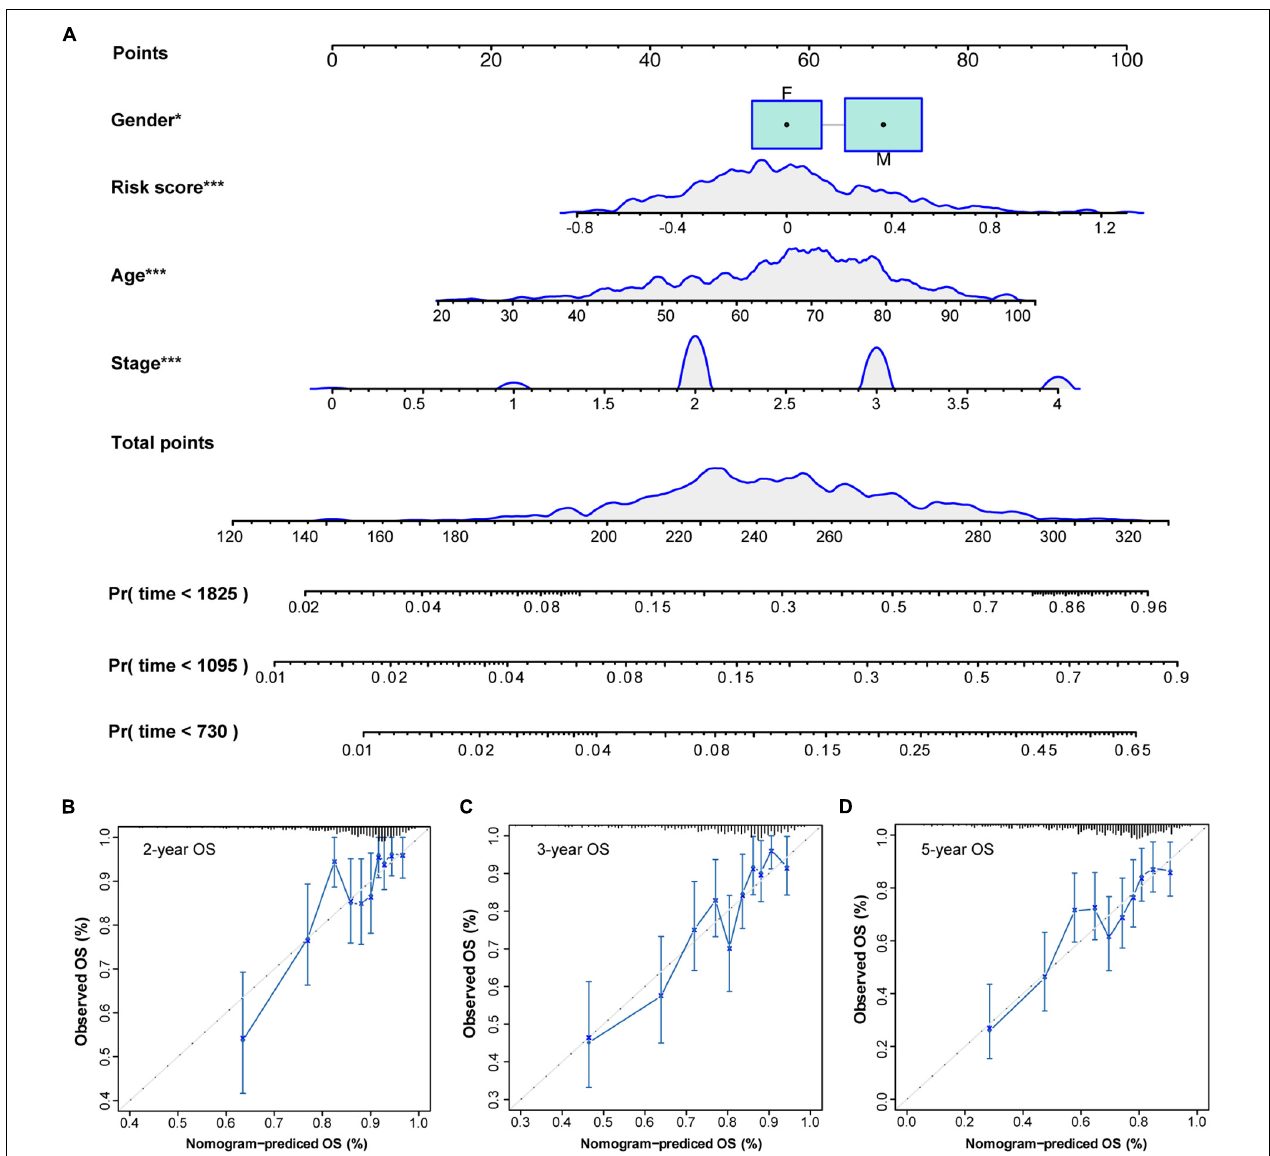
FIGURE 7 | A nomogram for predicting the probability of patient overall survival based on FRG signature and clinical factors. (A) A nomogram with FRG signature and clinical variables was built to quantify survival probability for individual CC patient. Survival time is measured in days. The independent prognostic factors including risk score, gender, age and stage were selected from multivariate Cox regression analysis. * p < 0.05; *** p < 0.001. (B–D) Calibration curves of the nomogram for predicting the 2-year (B) , 3-year (C) , and 5-year (D) survival probability. Closer alignment with the 45-degree line represents a better